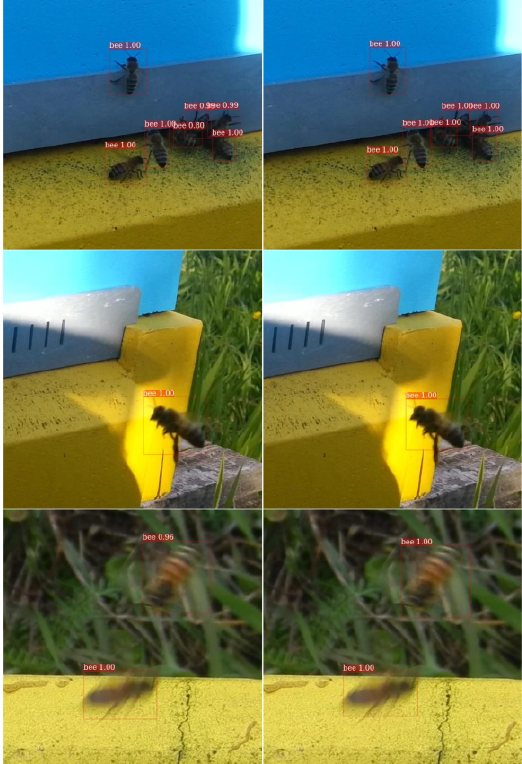
Figure 15. Bees detected by reference network ( left ) and the proposed model ( right )—image 1.